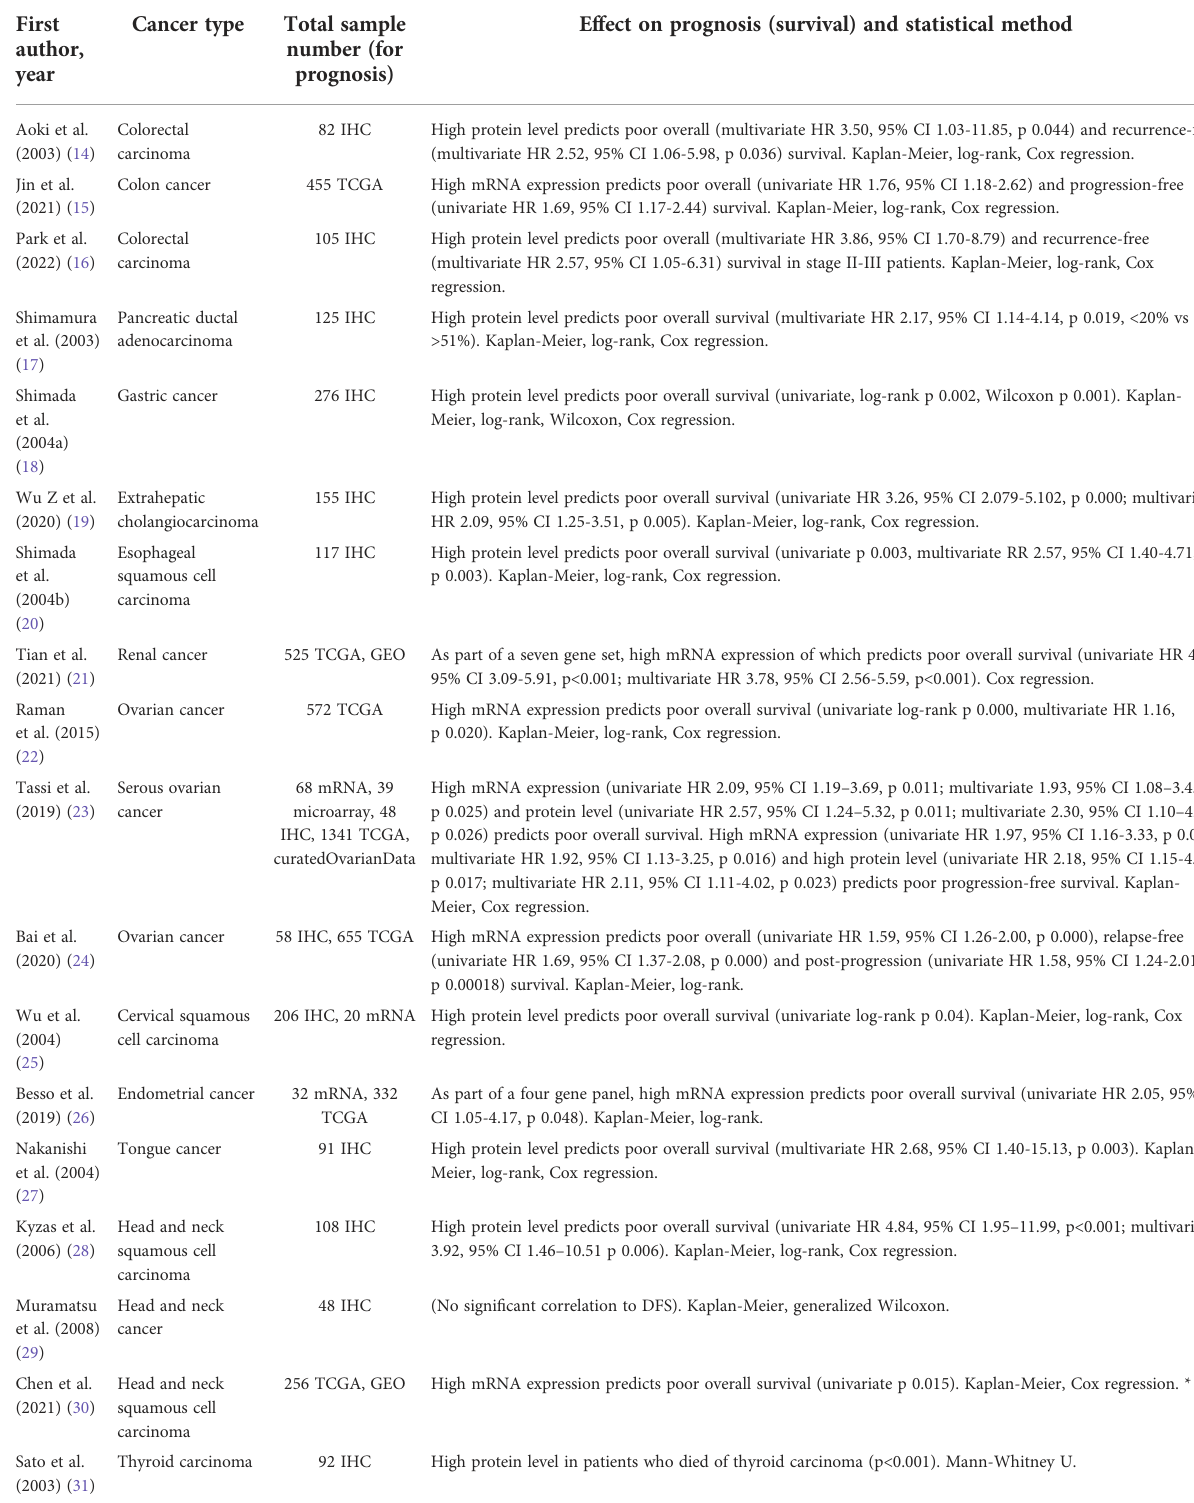
TABLE 1 Overview of reports (included in the systematic review) studying dysadherin in evaluating cancer